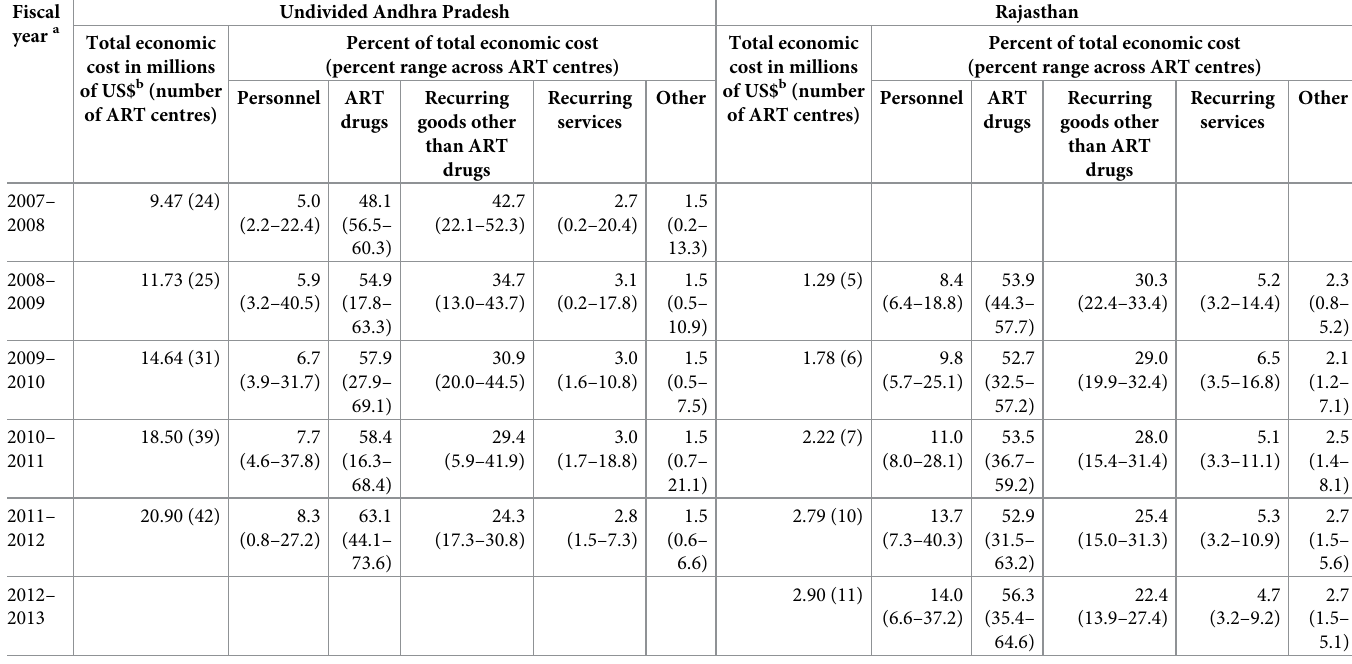
Table 2. Economic cost to public sector ART centres in undivided Andhra Pradesh and Rajasthan states in India from the fiscal years 2007–2008 to 2012–2013 a